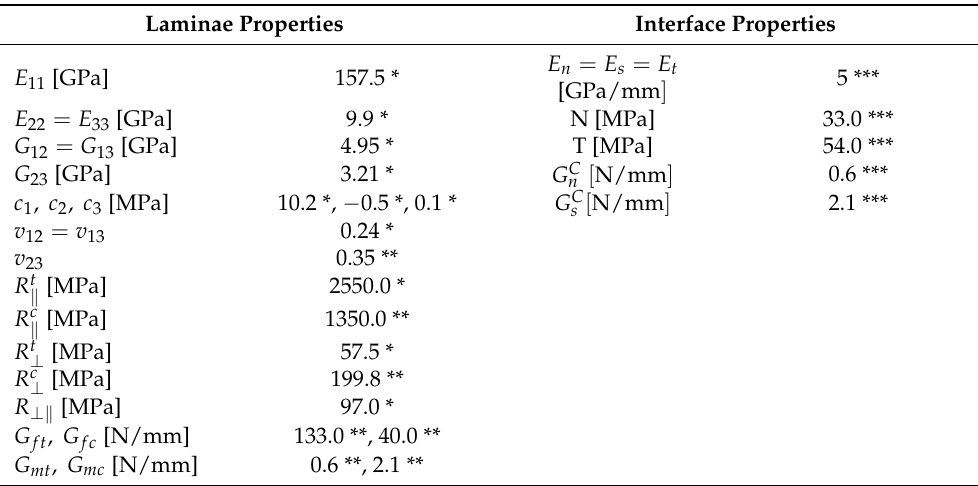
Table 1. Mechanical properties of CFRP